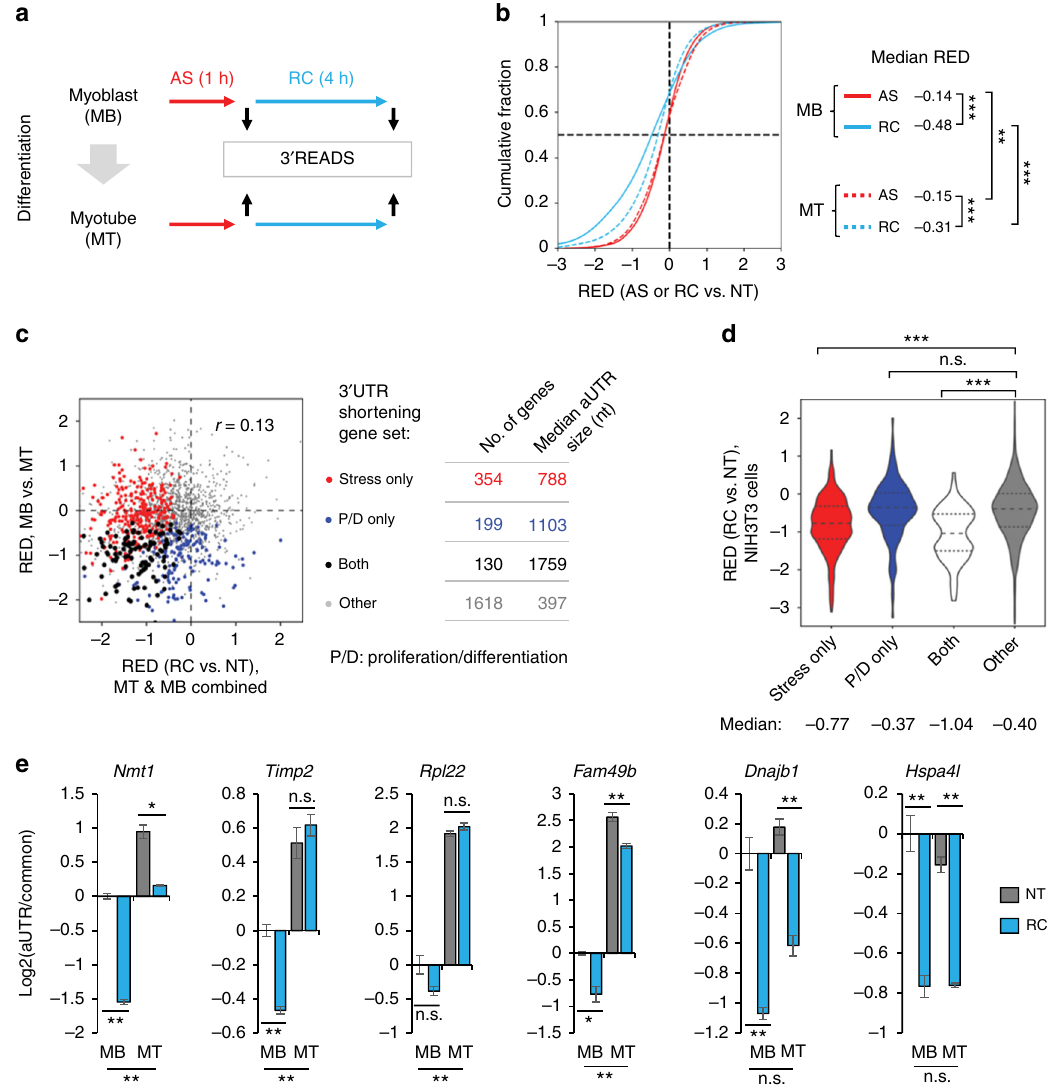
Fig. 7 Stress-elicited 3 ′ UTR shortening in proliferating and differentiated C2C12 cells. a Schematic of experimental design. b Distribution of 3 ′ UTR APA changes (RED) in proliferating C2C12 myoblast (MB) or differentiated C2C12 myotube (MT) cells after 1 h of arsenic stress (AS) or 4 h of recovery after stress (RC) as compared to non-treated (NT) cells. Median RED for each comparison is shown, re fl ecting overall 3 ′ UTR size change. The P -value (K – S test) indicating signi fi cance of RED difference is shown for each comparison. Three asterisks indicate P < 0.001 and two P < 0.01. c Comparison of stress-elicited 3 ′ UTR APA changes in MT or MB cells ( x -axis) and C2C12 proliferation/differentiation (P/D, y -axis). Pearson correlation coef fi cient is indicated. For x -axis, RED values of MT and MB cells were averaged. For P/D, two biological replicated were used. Genes were divided into four groups based on 3 ′ UTR size changes in stress and P/D conditions, i.e. Both, Stress only, P/D only, and Other. Genes with signi fi cant 3 ′ UTR shortening by stress were based on either MT or MB cells (a union set). Number of genes in each group and median aUTR size are shown. d Violin plots showing RED values in stressed NIH3T3 cells (4 h RC vs. NT, Fig. 1) for the four gene groups in c . The median of each is indicated. Signi fi cance of difference (Wilcoxon test) is indicated for comparing groups (***, P < 0.001; n.s., P > 0.05). e RT-qPCR analysis of 3 ′ UTR size changes by stress in MT or MB cells. Error bars are standard deviation based on two replicates. The signi fi cance of difference between MT and MB cells in the NT condition is also indicated. One asterisk indicates P < 0.1, two asterisks P < 0.05, and n.s. P > 0.1 (Student ’ s t